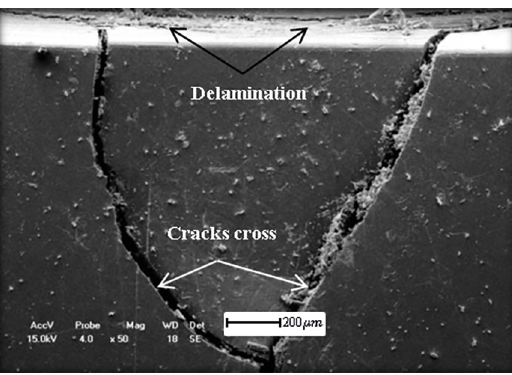
Figure 11. Fracture on the surface - HSCL